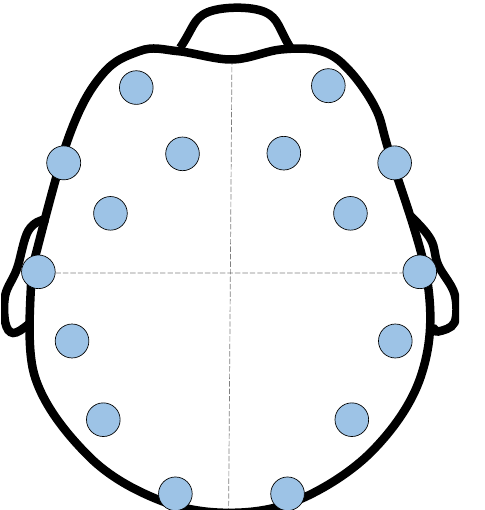
Figure 3. Fourteen channels for electroencephalogram (EEG)-signal acquisition using Emotiv